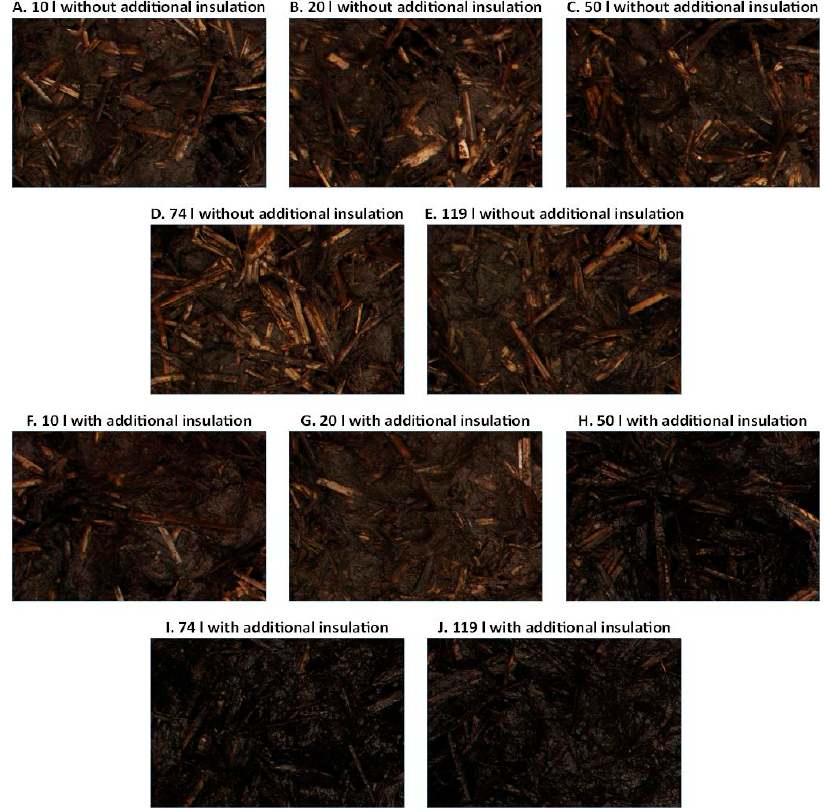
Figure 4. Exemplary images of samples of material produced in the considered composting chambers.